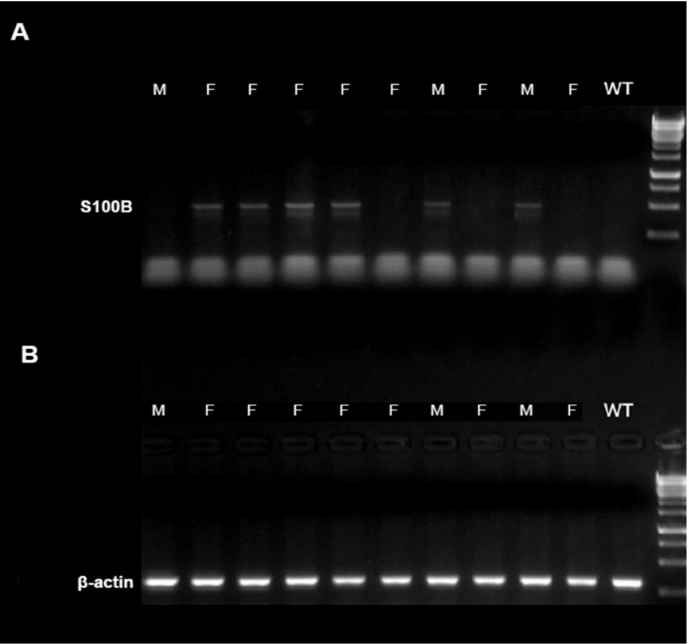
Figure 7. Characterization of S100Btg mice by genotyping. Genotyping of mice with the S100B gene was performed using standard polymerase chain reaction (PCR) of tail biopsies. Illustrative image of electrophoresis, in ( A ) S100B and ( B ) β -actin as control. F = female; M = male; WT = wild